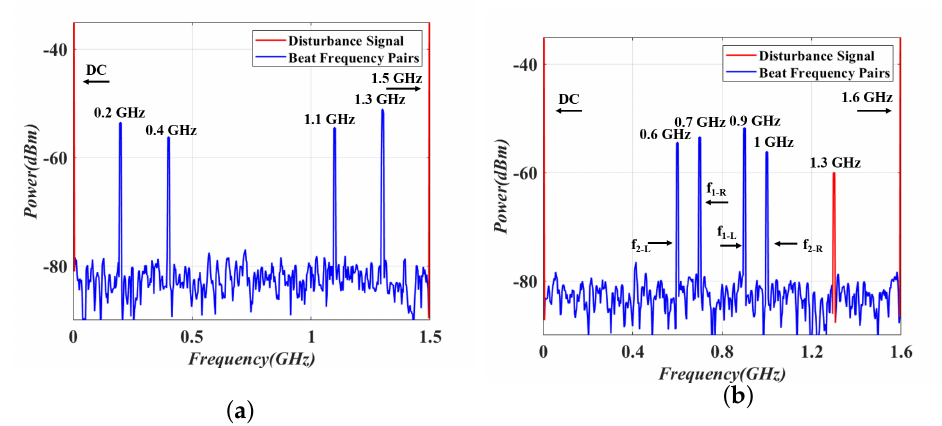
Figure 13. Receiving results for incoming signals at 7.3 and 8.6 GHz, where the comb spacing is ( a ) 1.5 GHz and ( b ) 1.6 GHz.